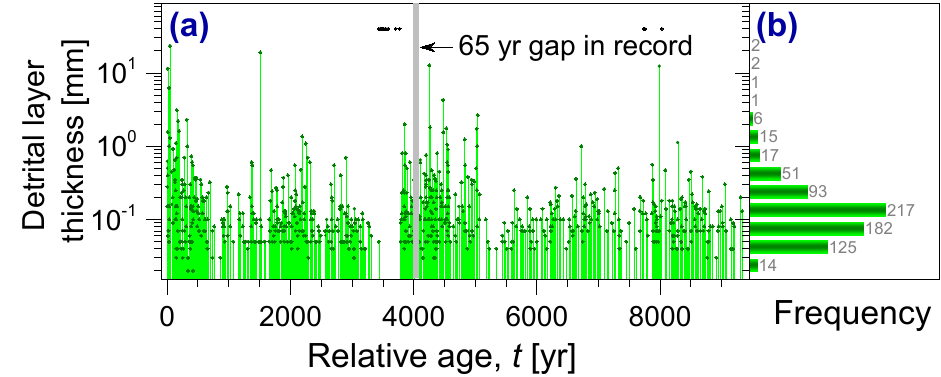
Figure A1. Detrital layer thickness: (a) thickness and temporal lo- cation of the detrital layers in the varved sediment; 771 layers are located within the 9271 varves. The x -axis represents relative age, with 0 years representing the most recent varve and increasing val- ues indicating further back in time. The grey bar represents a sed- iment gap of 65 years. The detrital layer thickness (green vertical bars), shown on a logarithmic scale, ranges from 0.002 to 23mm. Some layers are just reported and not measured (black dots in a horizontal line towards the top of panel a ). The detrital layers are unequally distributed over time. A histogram of the layer thickness is given in (b)